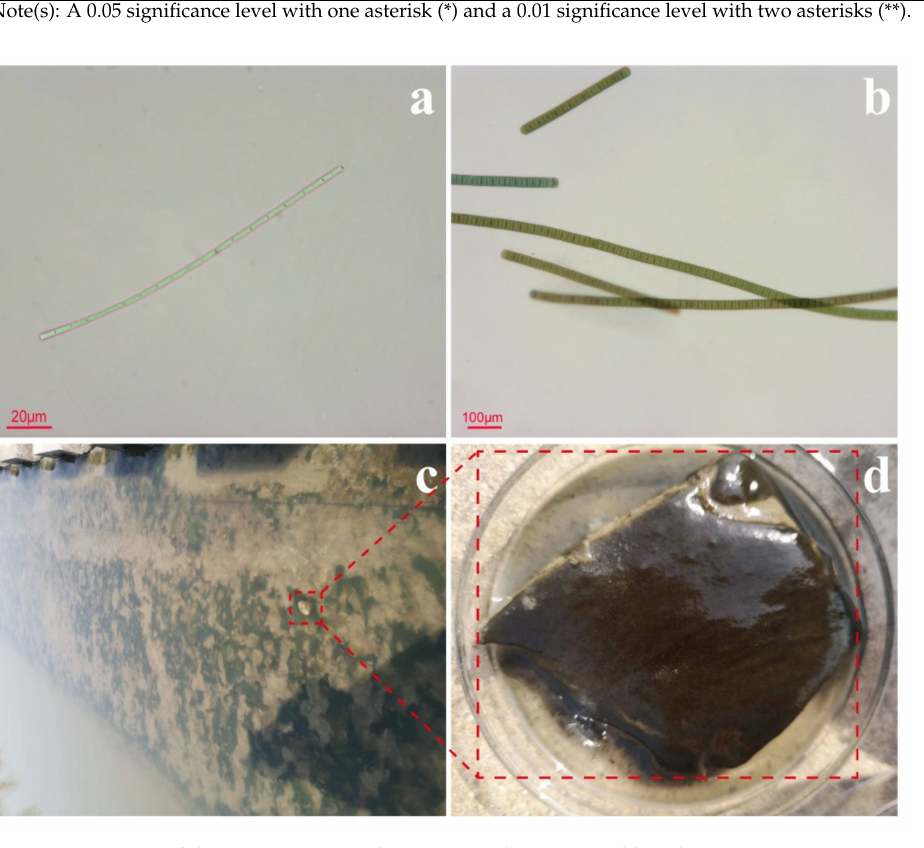
Figure 7. Images of the main MIB-producing cyanobacteria and benthic mats. Microscopic images of Pseudanabaena sp. ( a ) and Oscillatoria sp. ( b ). A long band of benthic mats (200 m × 3 m) full of brown patches developed all around the shallow water-distribution channel at the front end of the pretreatment zone ( c ). Thin biofilm of the brown patches ( d ), which was composed of benthic Oscillatoria ( b ). The Oscillatoria strain isolated from the biofilm could produce 2-MIB, as demonstrated by